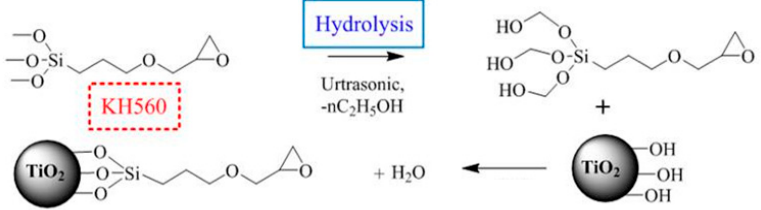
Figure 1. Reaction of surface functionalization of nano-TiO 2 and epoxy curing.